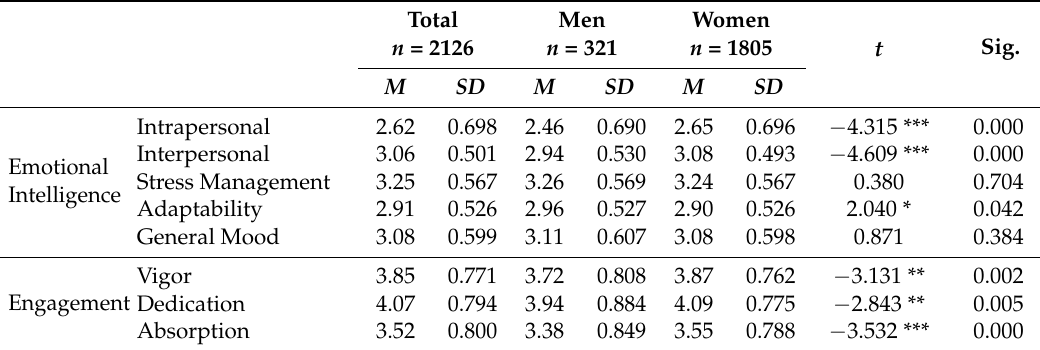
Table 1. Emotional intelligence and engagement. Descriptive statistics and t -test by